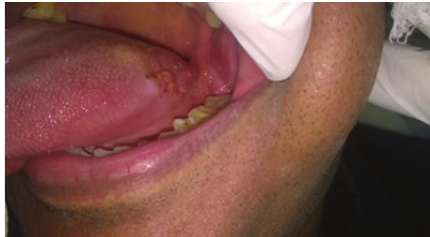
Figure 2: Ulcer with yellow crusted surface on the left posterolateral border of tongue.